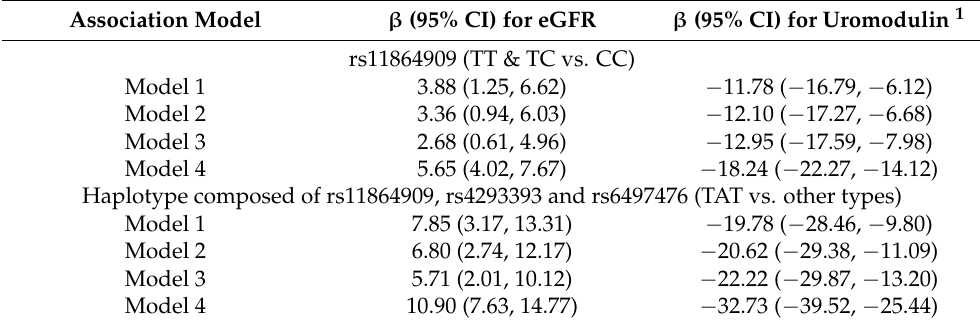
Table 2. Genotypes of rs11864909 and haplotypes involving rs11864909, rs4293393 and rs6497476 and eGFR or